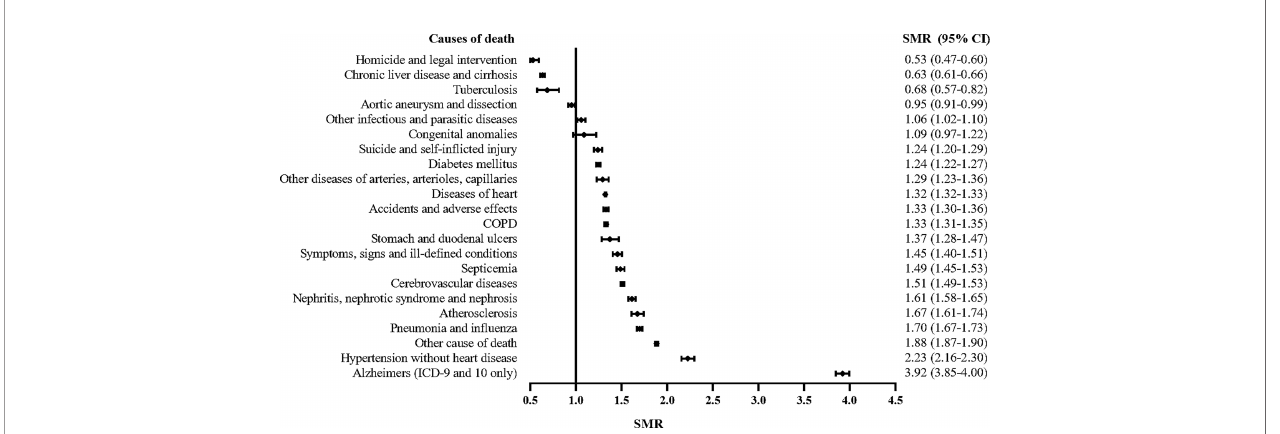
FIGURE 2 | Forest plot showing the SMRs of different non-cancer of death in ranked order.